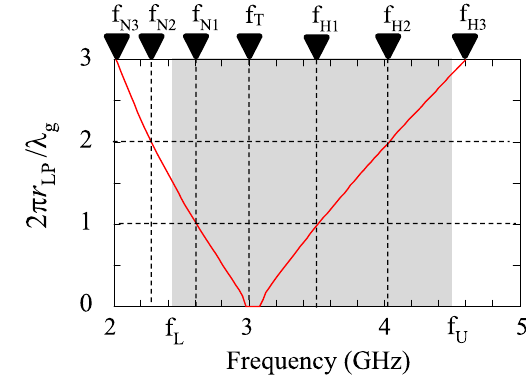
Fig. 9. Normalized loop circumference 2 p r LP / l g as a function of frequency, where the radius of the metaloop is r LP =